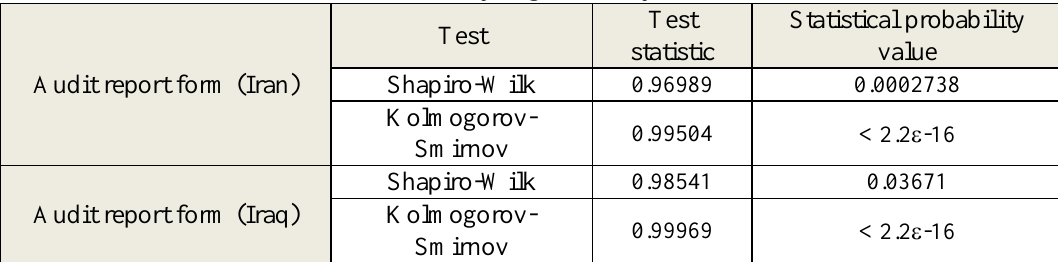
Table 4. Analyzing normality of